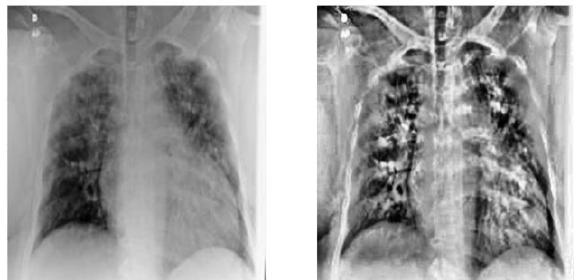
Figure 4.2: Neural Model Layers Based on the model composition, a sample image is used to test the functionality of the model, as shown in Figure 4.3. The model predicts if the patient is infected or not, based on the CT scan, and also a mathematical analysis of how probable the chances of infection are. The same is also tested by locating the nodes of infection, in Figure 4.4. The colored regions (red, orange, green) represent the regions where the COVID-19 virus is predominantly present. This includes presence of GGOs, Reverse Halo, and so on.